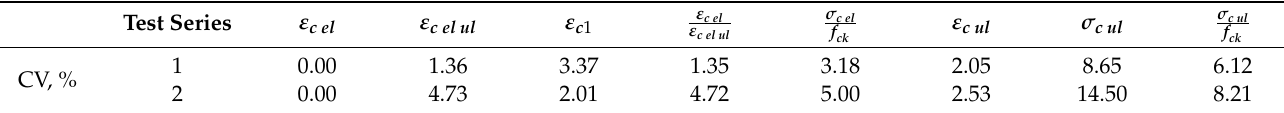
Table 4. Variation coefficients for the 𝜎 (cid:3030) − 𝜀 (cid:3030) -diagram-controlled parameters.